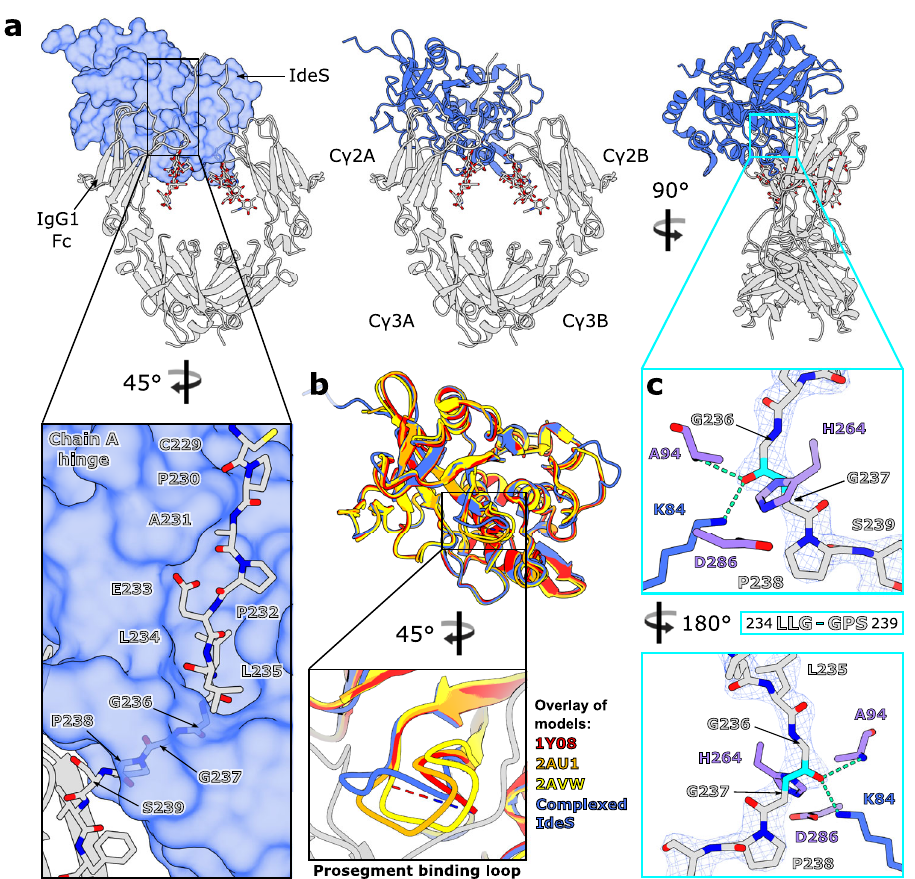
Fig. 2 | Crystal structure of IgG1 Fc E382A -IdeS C94A complex. a Overall structure of complex, with IdeS C94A shown as a surface and IgG1 Fc E382A shown as a cartoon. N-linkedglycansand the IgG1 Fc E382A hingepeptide inthe focused panelare shown as sticks and coloured with oxygen, nitrogen and sulphur atoms in red, blue and yellow, respectively. b Superposition of complexed IdeS C94A with three published apostructuresofIdeS(PDBIDs1Y08,2AU1and2AVW,colouredinred,orangeand yellow, respectively) and focused view of the prosegment binding loop. c Binding